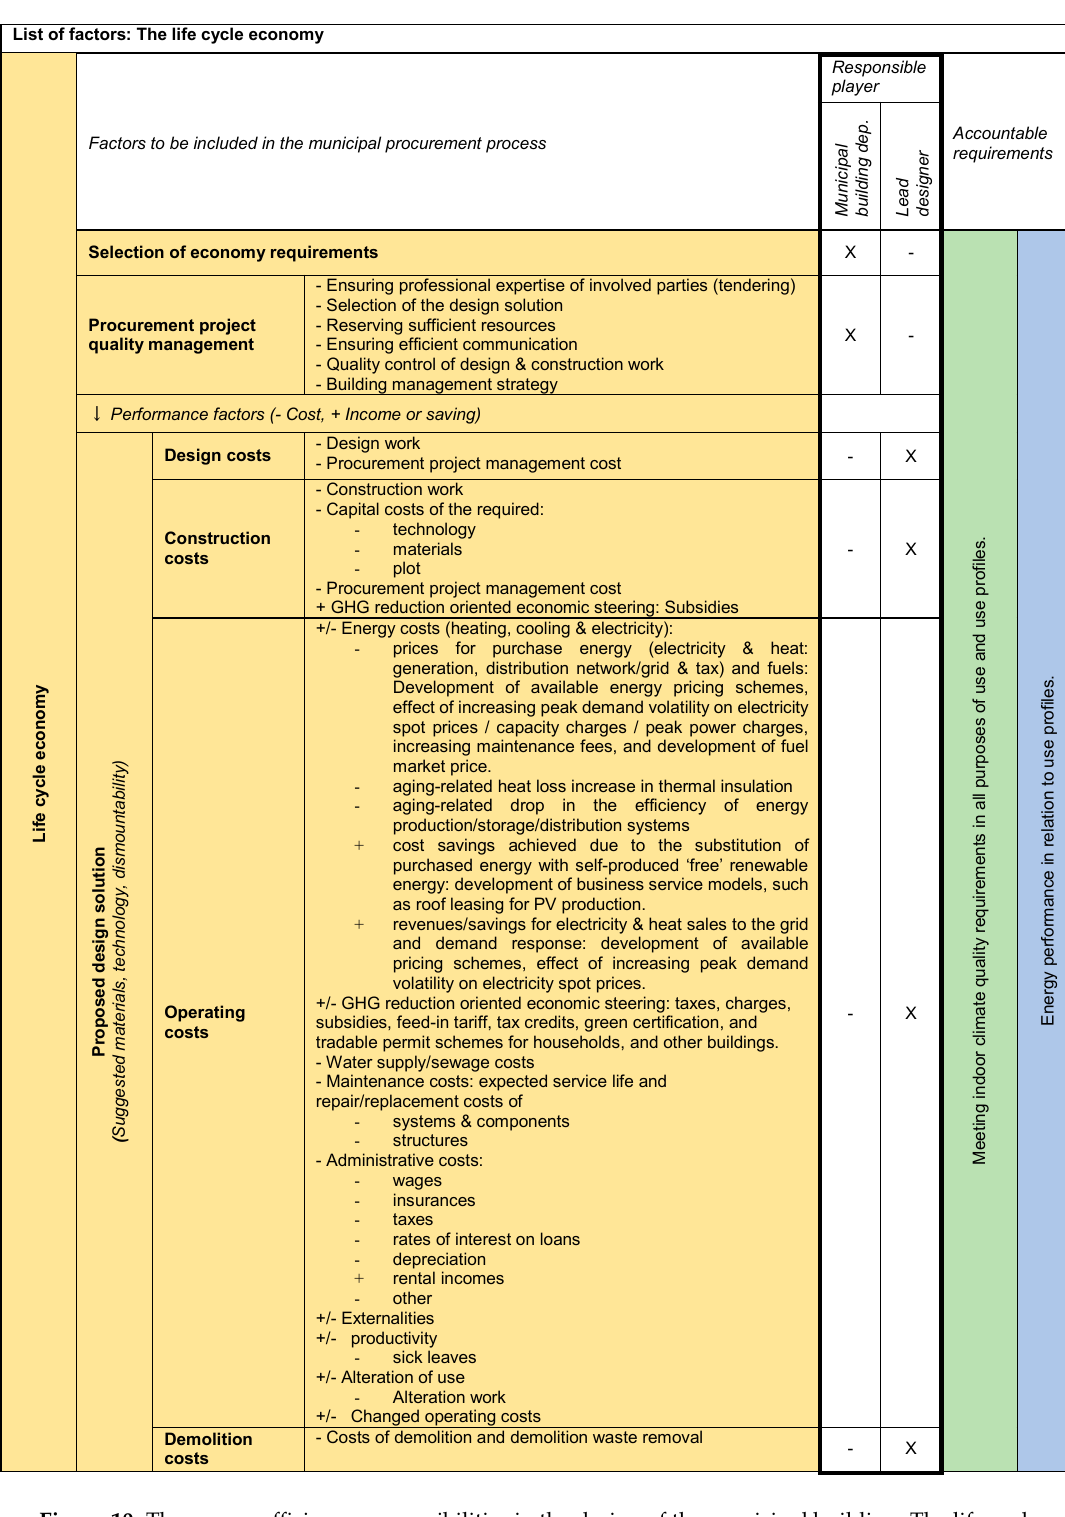
Figure 10. The energy efficiency responsibilities in the design of the municipal building: The life cycle costs of a building. Based on